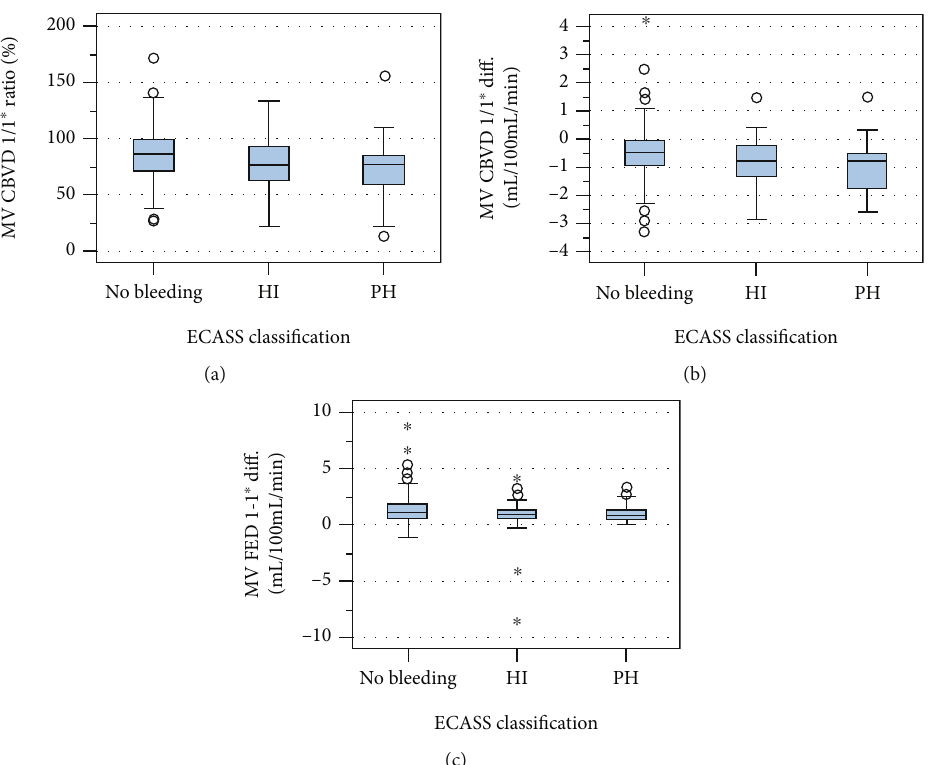
Figure 3: (a) Mean values of the CBV in the deep MCA ROI of the a ff ected hemisphere relative to the contralateral hemisphere in percent (1/1 ∗ ratio). (b) Absolute di ff erences between the mean values of the CBV in the deep MCA ROI of the a ff ected hemisphere and the contralateral hemisphere (1-1 ∗ Di ff .). (c) Absolute di ff erences between the mean values of the FED in the deep MCA ROI of the a ff ected hemisphere and the contralateral hemisphere (1-1 ∗ Di ff .). Abbreviations: CBV, cerebral blood volume, FED, fl ow extraction product; HI, hemorrhagic infarction; PH, parenchymal hematoma; MCA, middle cerebral artery; and ROI, region of